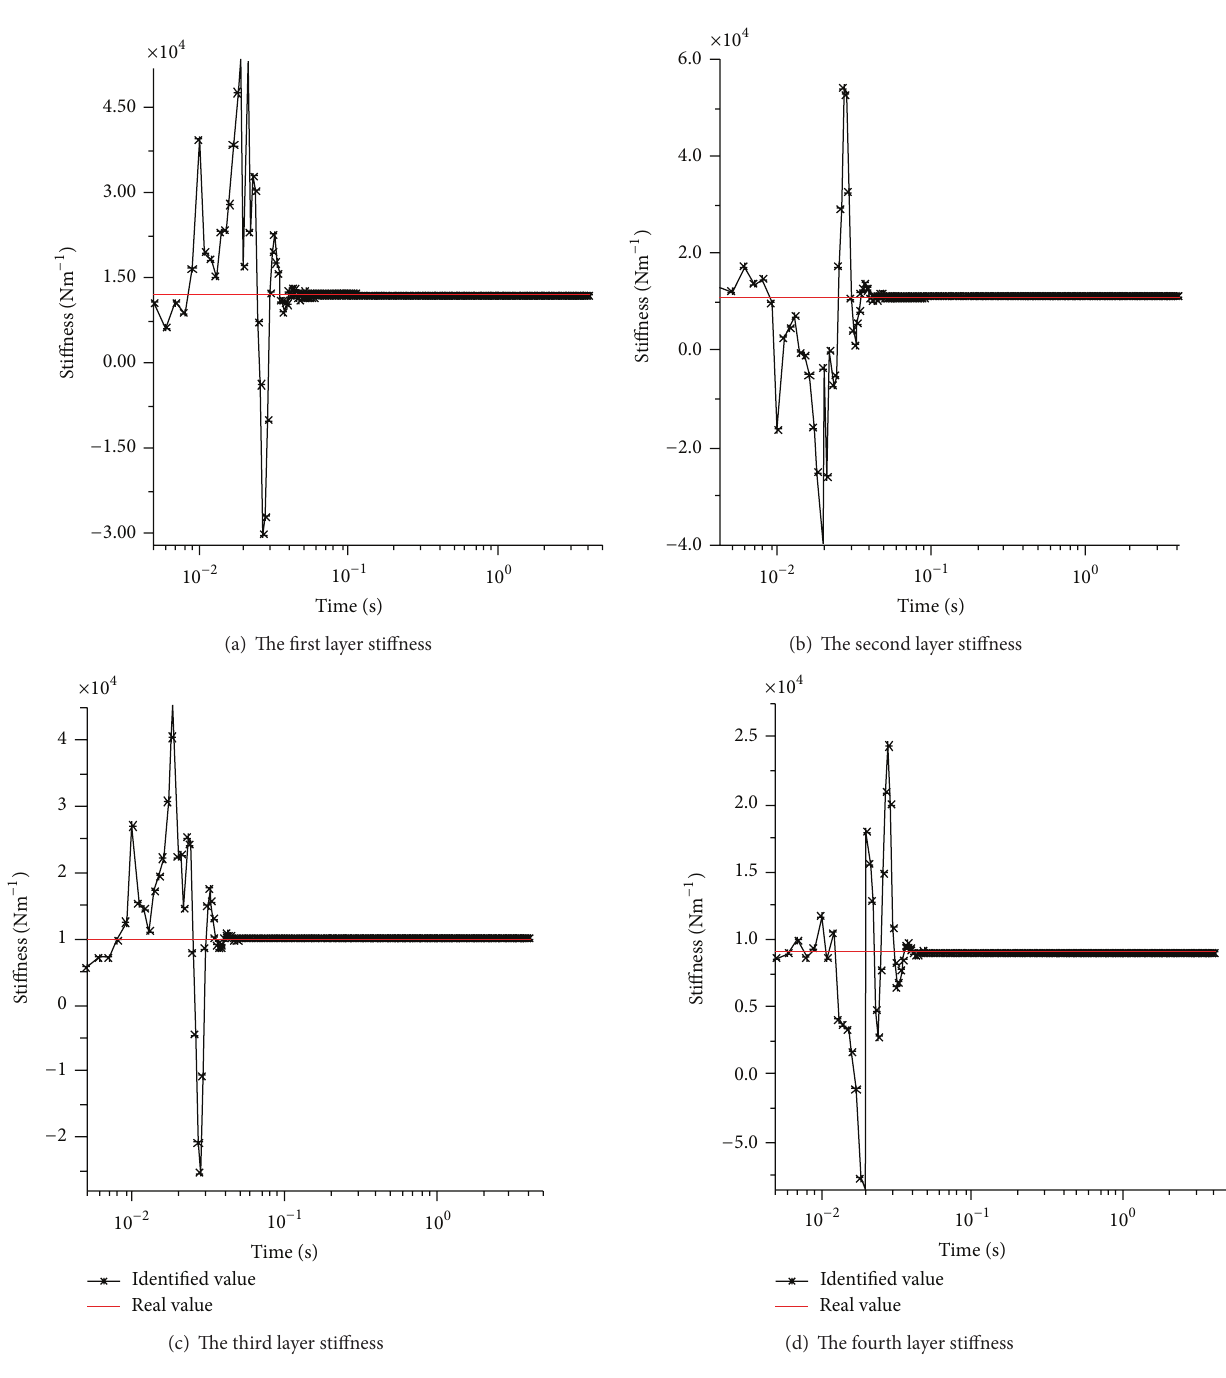
Figure 2: Structural stiffness identification result without